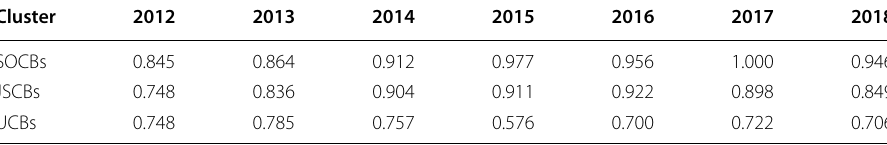
Table 7 Efficiency of the financing stage from 2012 to 2018